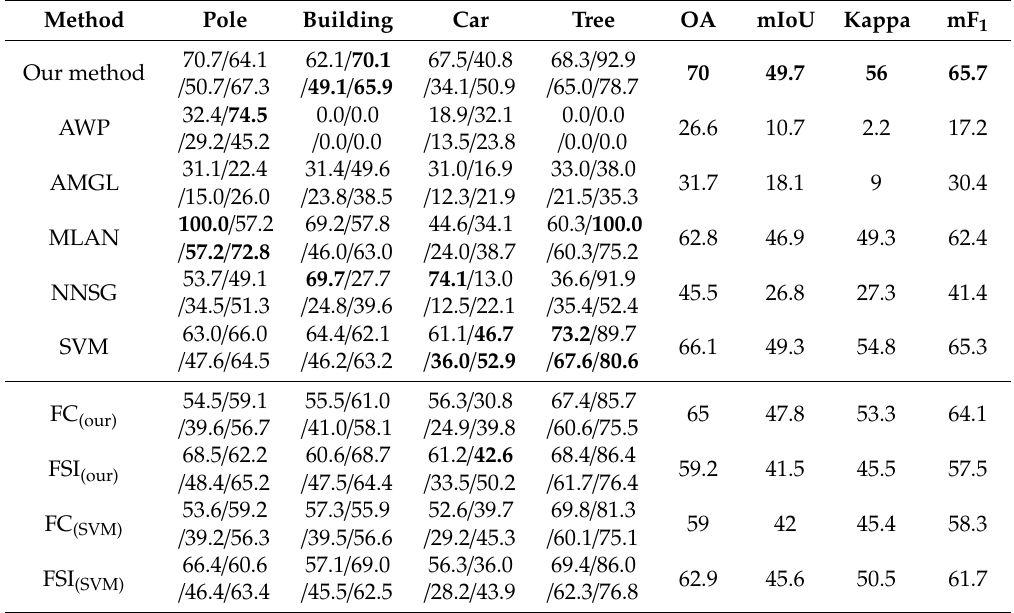
Figure 7. Classification results of MLS point cloud selected from Scene3. ( a ) Ground truth; ( b ) our method; ( c ) AWP; ( d ) AMGL; ( e ) MLAN; ( f ) NNSG. Note that our method obviously outperforms other methods in black box regions. Table 9. Classification results of Scene3 (%). Precision / recall / IoU / F 1 -score, OA, mIoU, Kappa and mF 1 (%). Note the highest accuracy values are highlighted in bold.